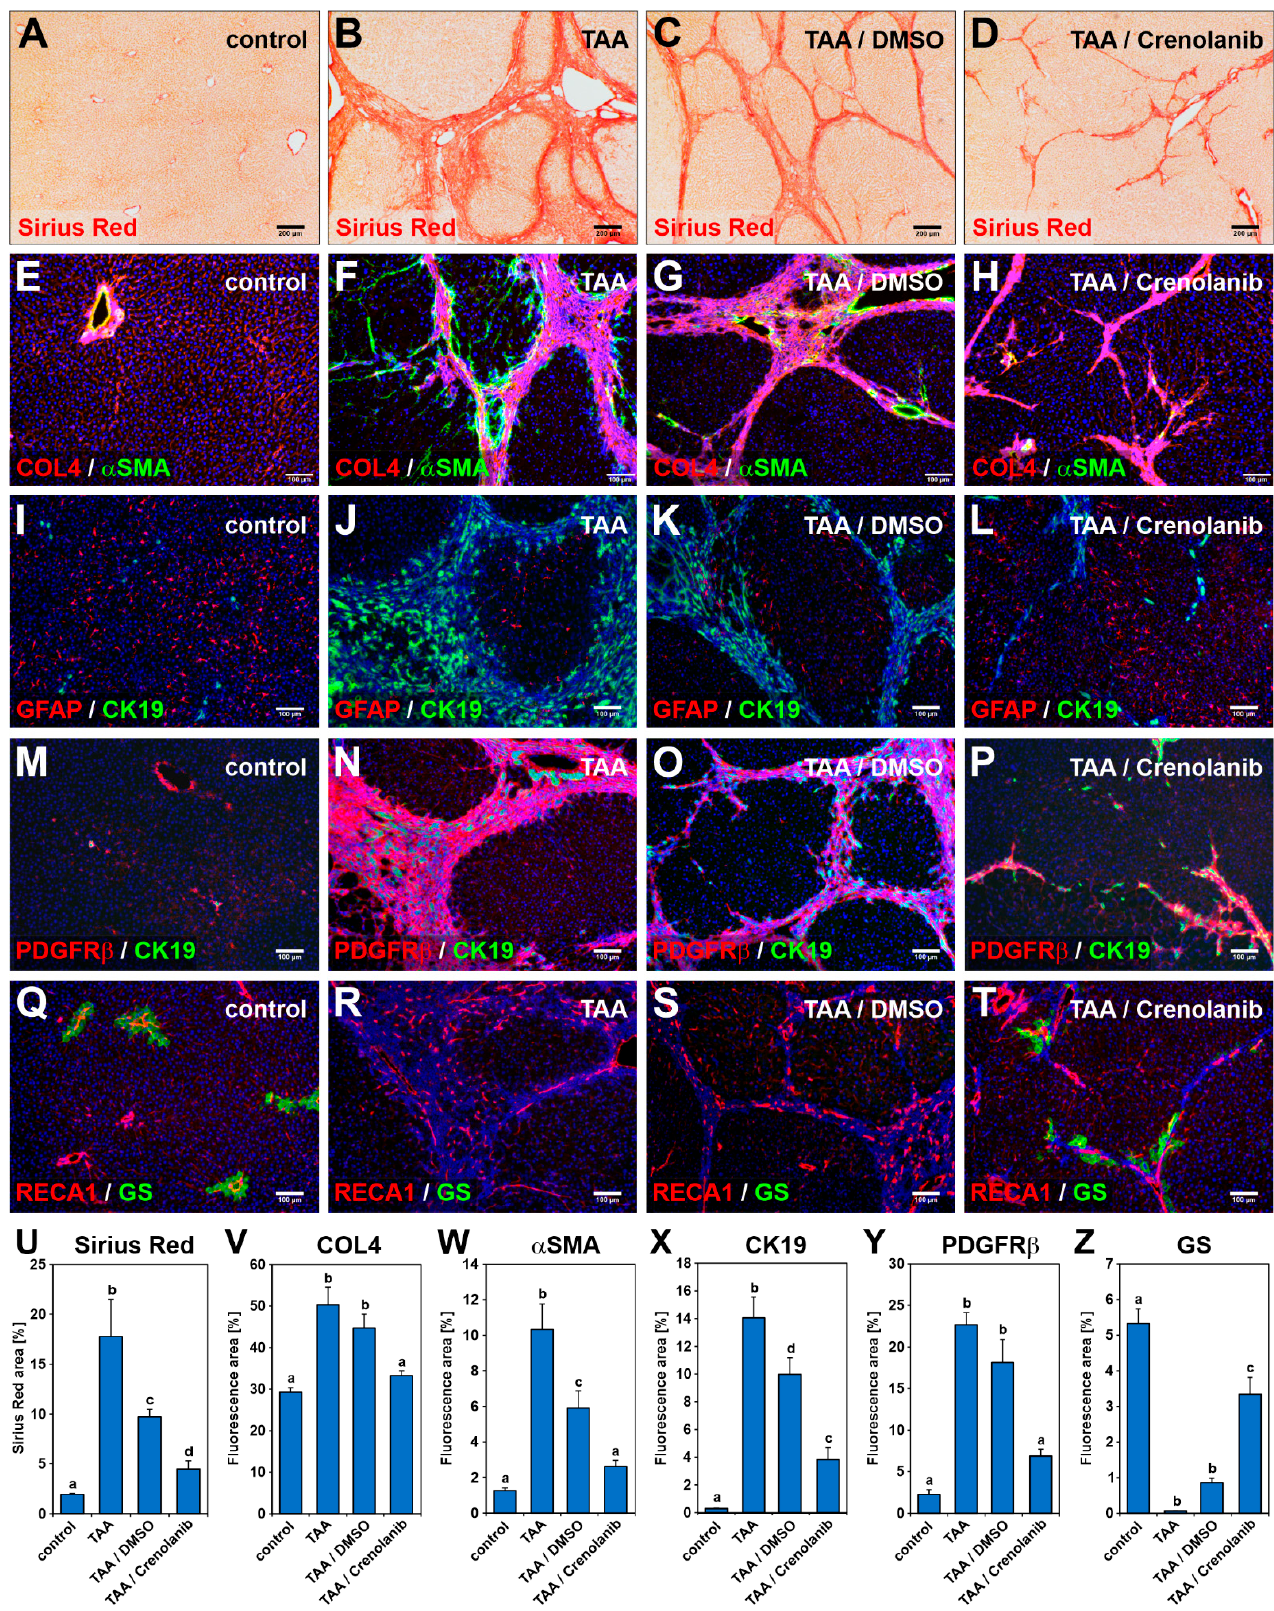
Figure 2. Crenolanib treatment improves liver fibrosis regression. Rats received ( A , E , I , M , Q ) normal (control) or ( B , F , J , N , R ) TAA-enriched drinking water for 18 weeks to induce liver fibrosis. After fibrosis induction, the rats were either treated with ( C , G , K , O , S ) DMSO or ( D , H , L , P , T ) Crenolanib (0.05 mg/mL) dissolved in DMSO for 14 days. Cryosections of liver